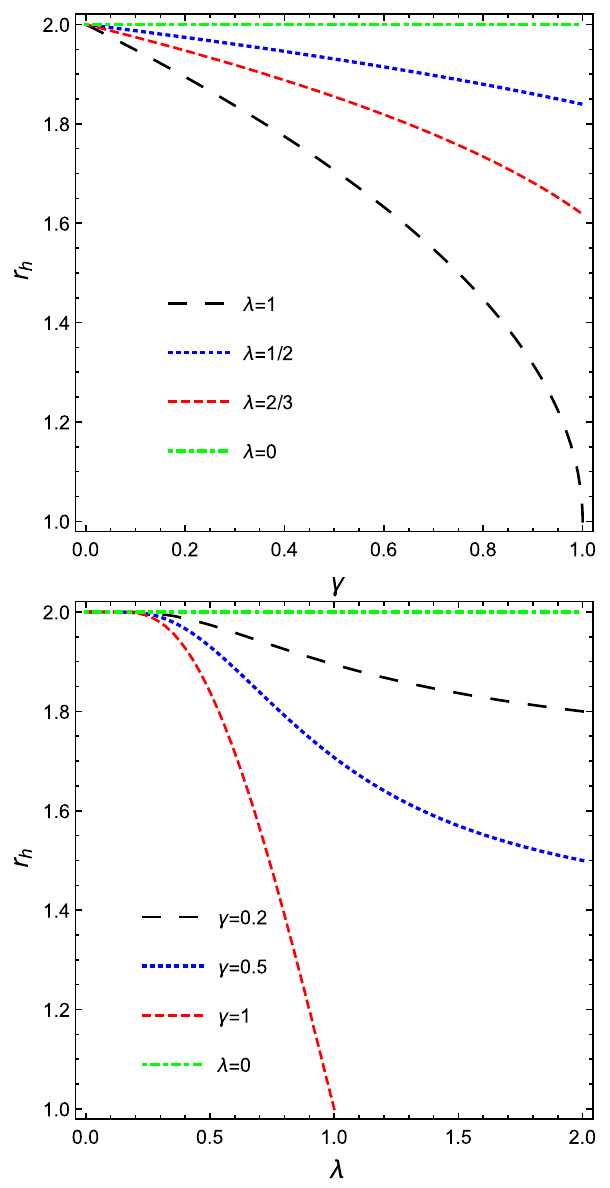
Fig. 1 Dependence of the event horizon radius r h on parameters γ and λ for BH in KR gravity and we use M =